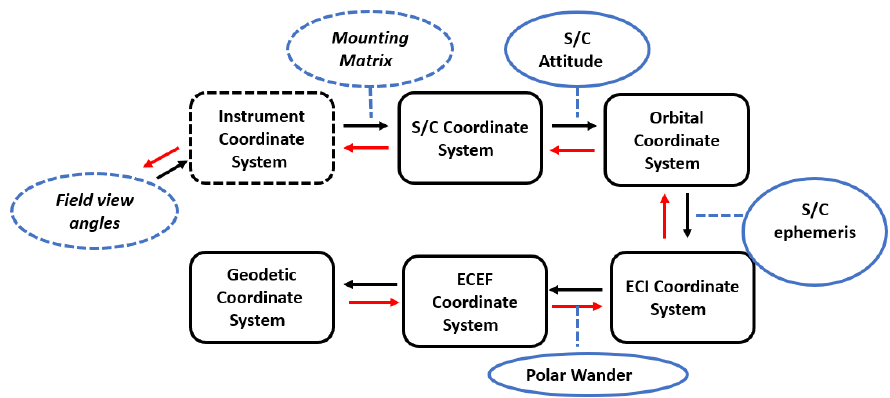
Figure 2. Flowchart that illustrates the procedures for OMPS-NM geolocation calculation, in which the black and red arrows indicate the forward and inverse geolocation calculations, respectively. The blocks with the dashed line represent the sensor-specific algorithm, while the blocks with the solid lines stand for the spacecraft-level algorithm. The blue blocks are the data used for the coordinate transformation, where the field angles and mounting matrix are static, but others are dynamic (varying with time).